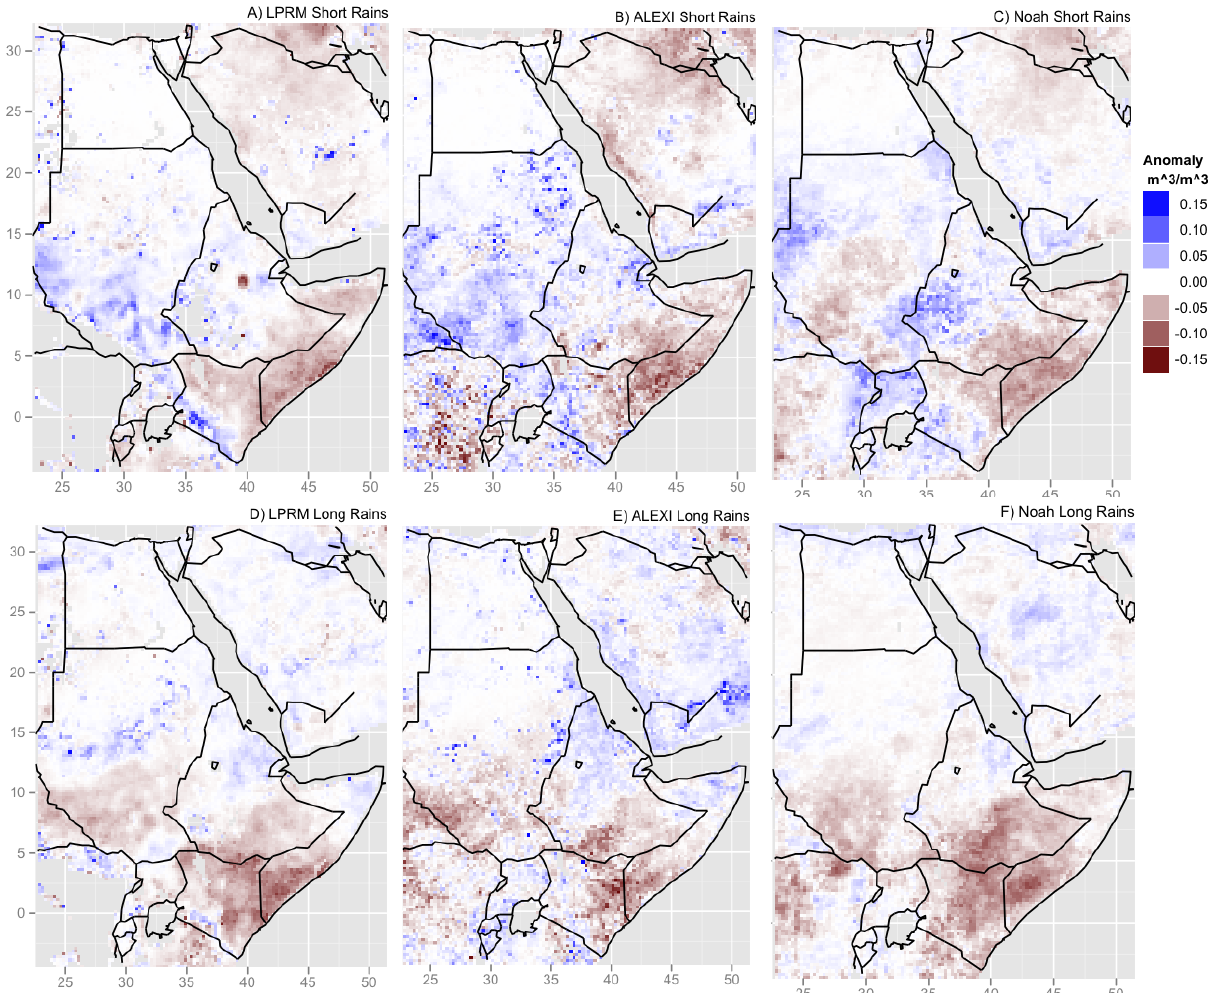
Fig. 4. Seasonal anomalies averaged over the 2010 short rains (A–C) and 2011 long rains (D–F) for LPRM (A, D) , ALEXI (B, E) and Noah (C, F) . The short rains are defined as the period from 12 September–1 December, while the long rains span 28 March –30